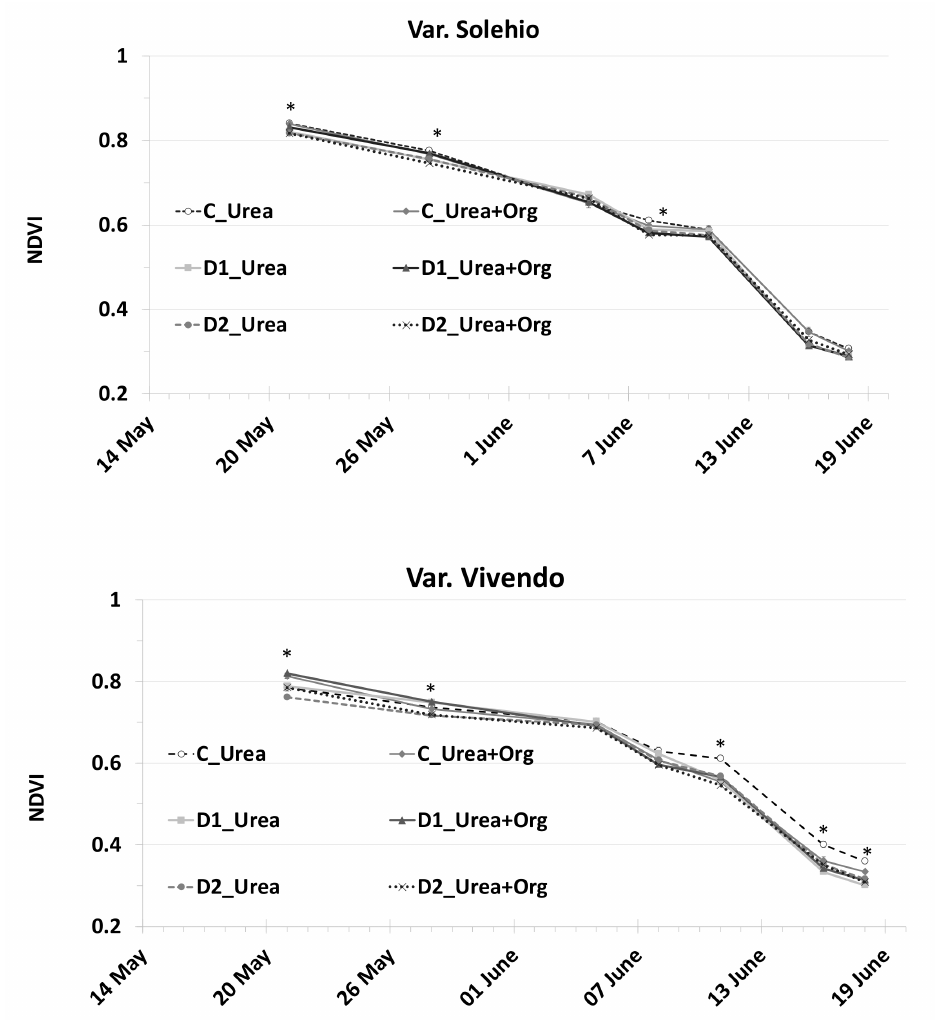
Figure 1. Dynamics of normalised difference vegetation index (NDVI) from earing to maturity ( n = 3) in wheat varieties Solehio and Vivendo following the biofortification treatment (on 14 May) at D1 and D2 doses of Ca + Mg + K and in the controls C_Urea and C_Urea + Org. Asterisks